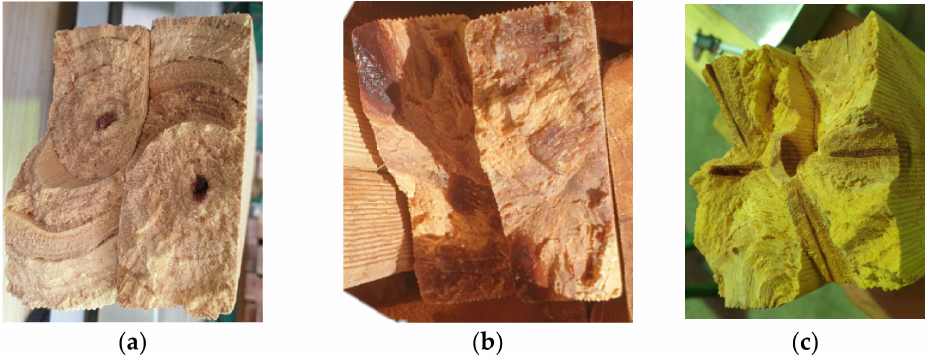
Figure 28. Some typical tension failures in ( a ) clear, ( b ) resin and ( c )